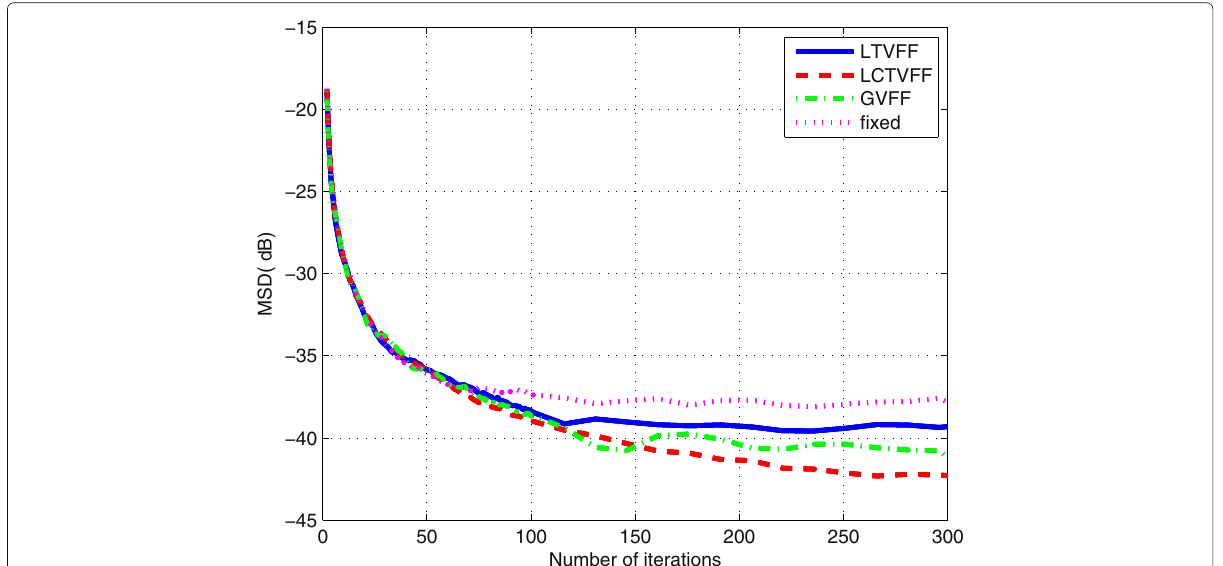
Fig. 15 MSD performance for different algorithms applied in distributed spectrum